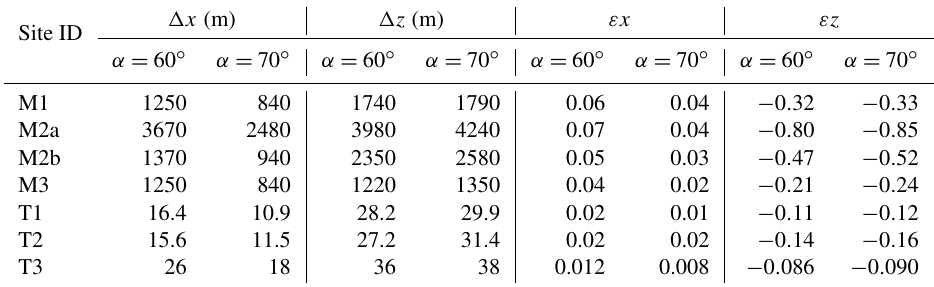
Table 3. Ridge deformation in response to DSGSD in Valles Marineris and the Tatra Mountains. (cid:49)x : cumulated horizontal ridge elongation; (cid:49)z : cumulated vertical shortening; εx : horizontal strain (horizontal displacement normalised to ridge width in Table 1); εz : vertical strain (vertical displacement normalised to ridge height). Elongation is positive and shortening is negative. 2a assumes that the central valley in Site 2 is of purely DSGSD origin, whereas 2b assumes that the central valley has a purely glacial origin. Hypothesis (b) is considered to be more likely (see Sect.